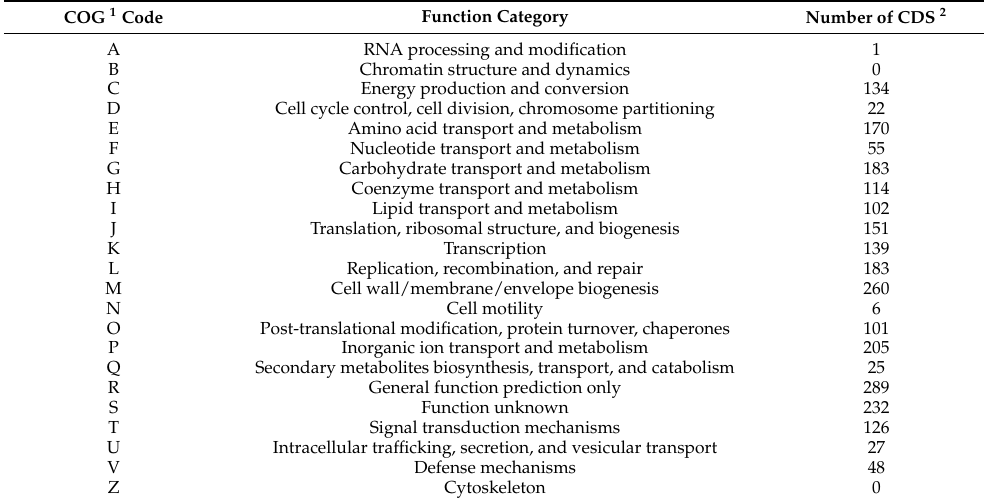
Table 2. COG stat of genome features of F. faecale WV33 T